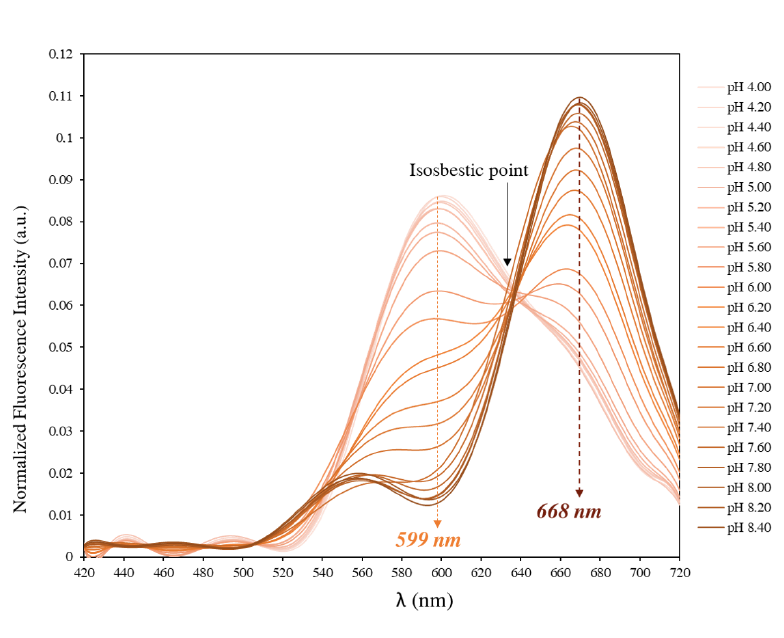
Figure 1. Emission spectra of SNARF-4F in DMEM serum-free medium at various pH values. SNARF-4F exhibits a double emission peak at 599 nm and 668 nm with an isosbestic point at 638 nm (pH-independent). Excitation wavelength is 514 nm.